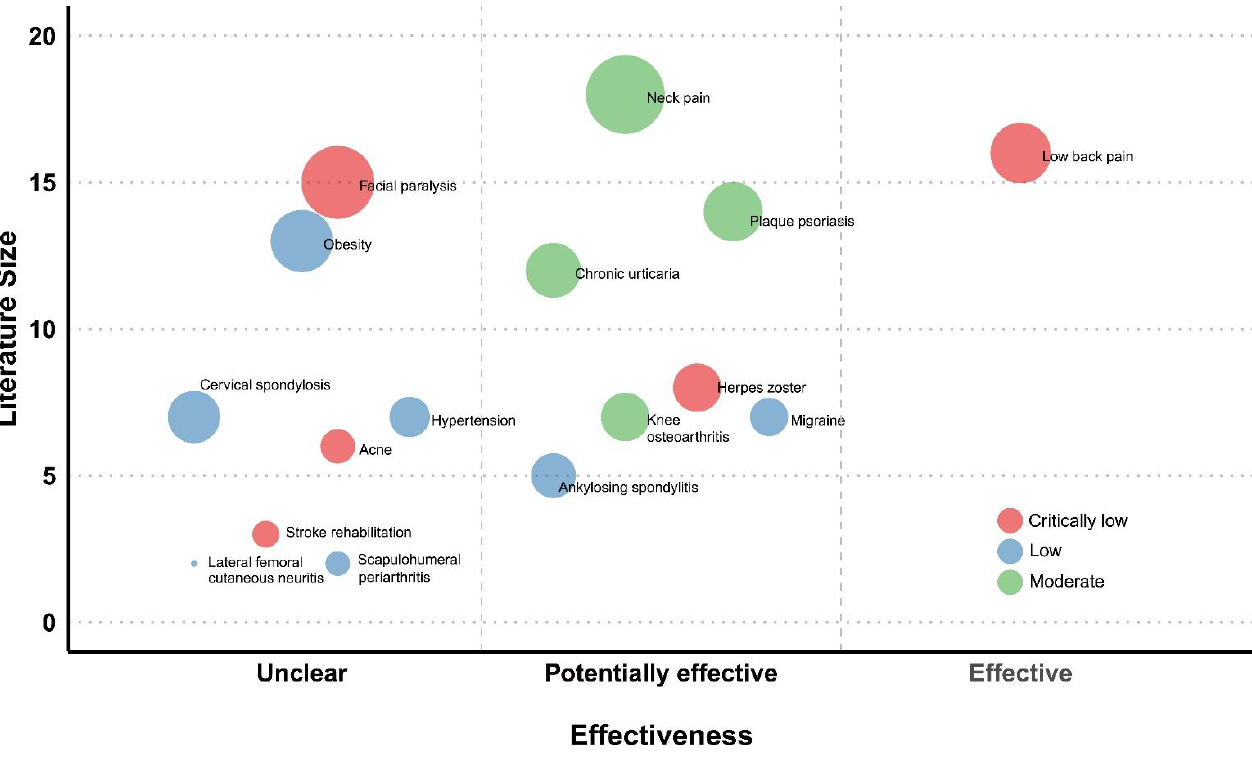
Figure 2. Evidence map of cupping therapy.